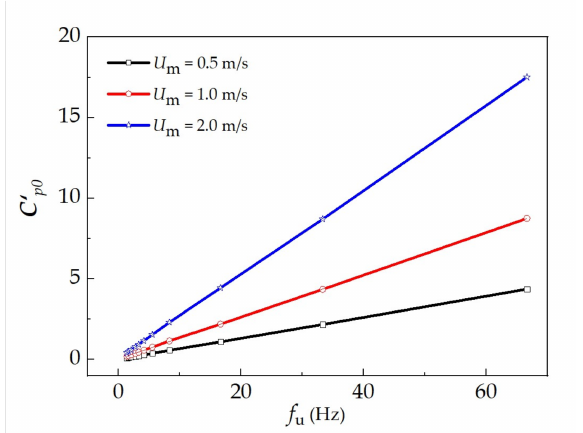
Figure 7. RMS pressure coefficients at the stationary point ( x = − 0.14, y = 0) in the streamwise sinusoidal oscillating flows.